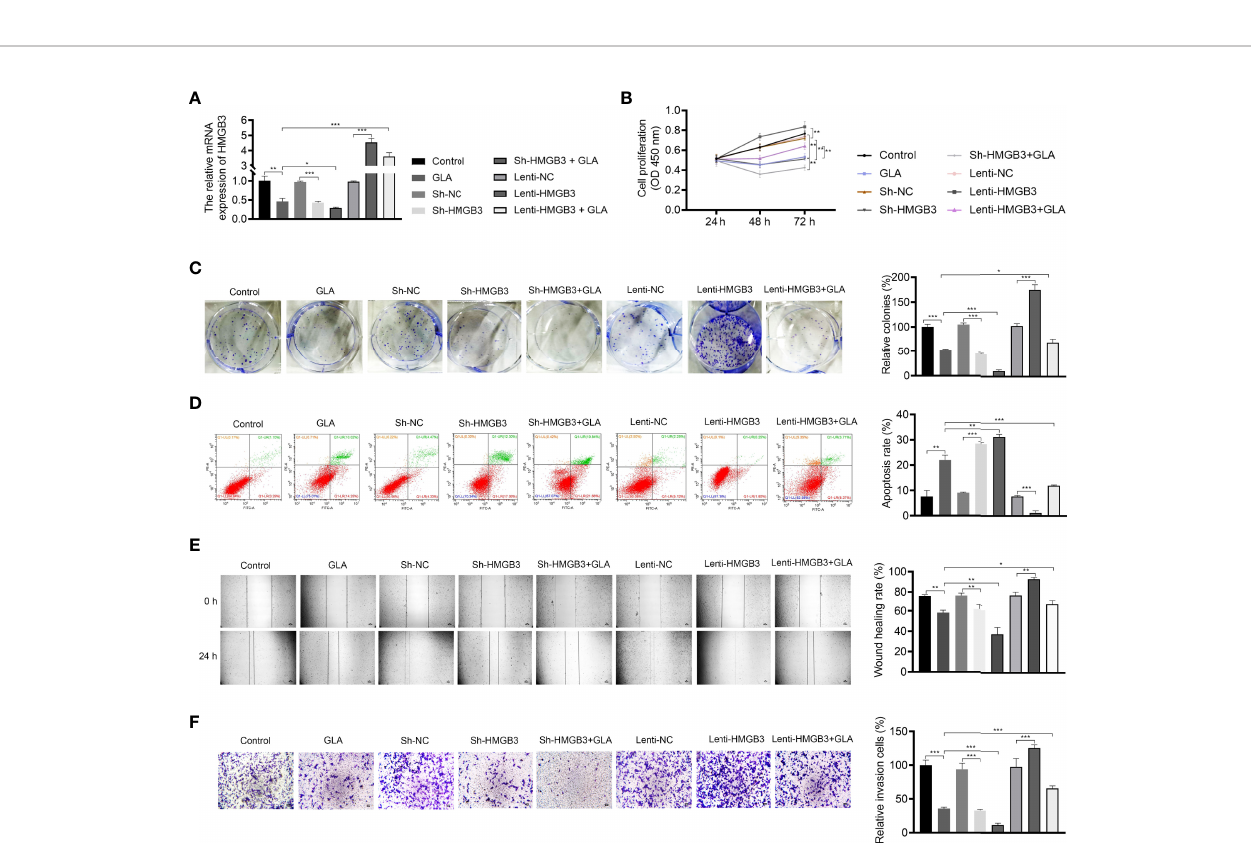
FIGURE 3 | GLA inhibited the malignant characteristics of EOC cells by regulating HMGB3. (A) The relative mRNA expression of HMGB3 in SKOV3 cells was measured by qPCR. (B) The viability of SKOV3 cells was detected by CCK-8 assay. (C) The proliferation of SKOV3 cells was detected by colony formation assay. (D) The apoptosis of SKOV3 cells was detected by fl ow cytometry. (E) The migration of SKOV3 cells was detected by wound healing assay. (F) The invasion of SKOV3 cells was detected by the Transwell assay. Scale bar = 50 µm. SKOV3 cells were treated with GLA, sh-HMGB3/sh-NC, and/or lenti-HMGB3/lenti-NC. * P < 0.05, ** P < 0.01, *** P <